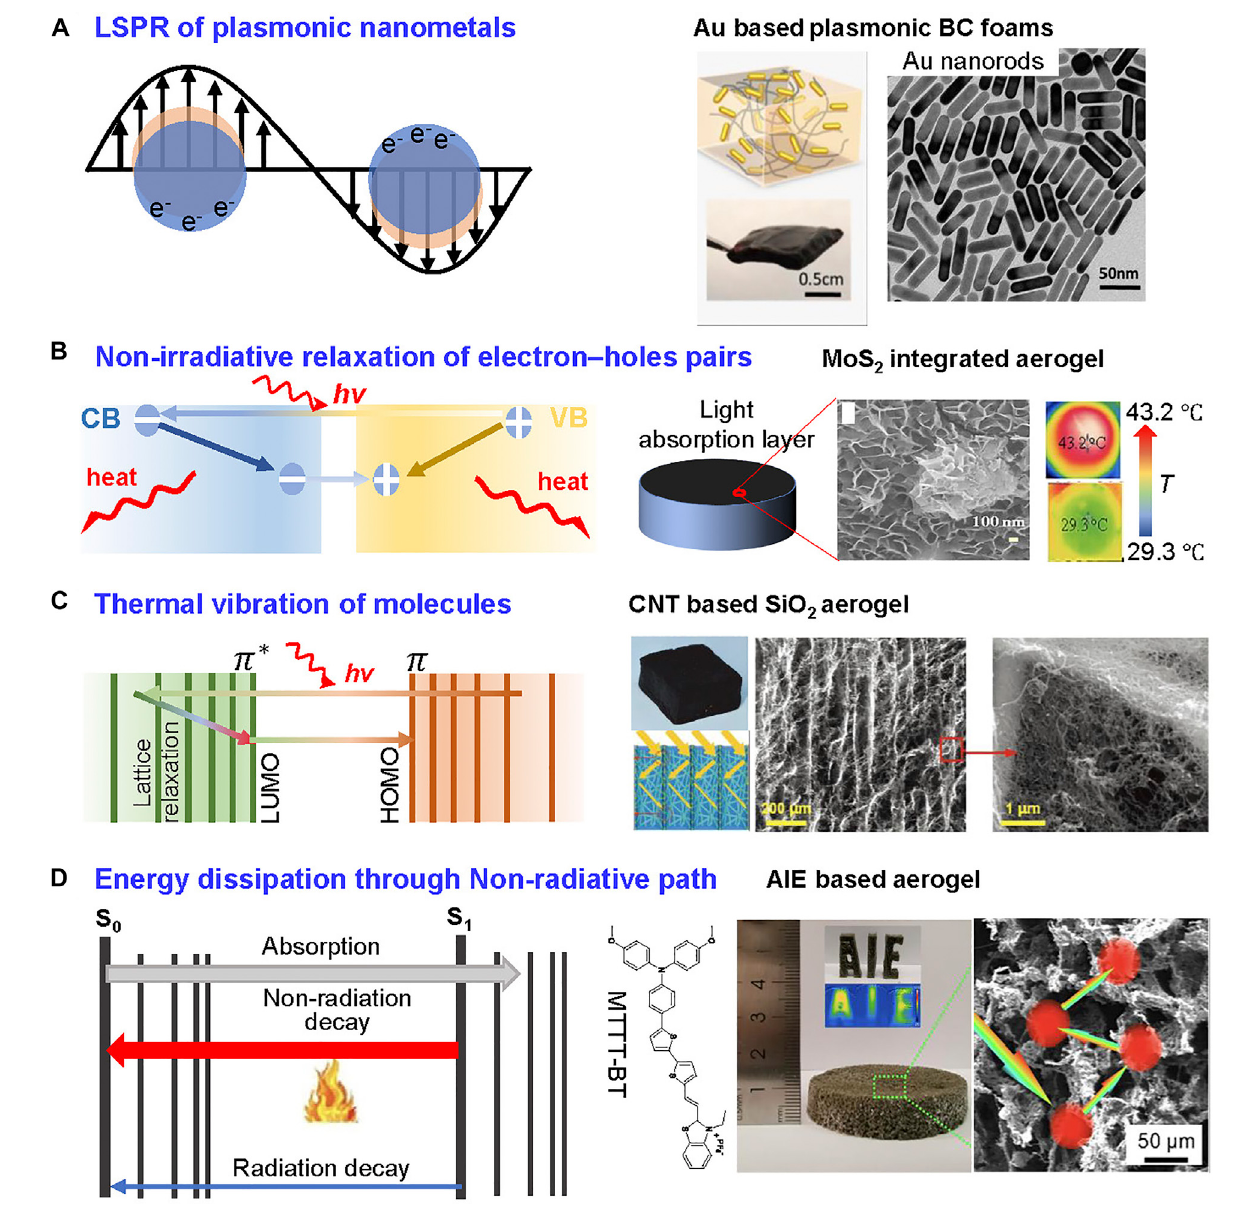
FIGURE 6 | Photothermal mechanisms of various types of photothermal materials and their corresponding demonstrations. (A) (left) LSPR effect of plasmonic nanometals (Wang et al., 2019). (right) Plasmonic materials to maximize solar radiation absorption made from gold nanorods and their application as photothermal materials in SVG. Reprinted with permission from (Tian et al., 2016). Copyright (2016) American Chemical Society. (B) (left) Non-irradiative relaxation of electron – holes